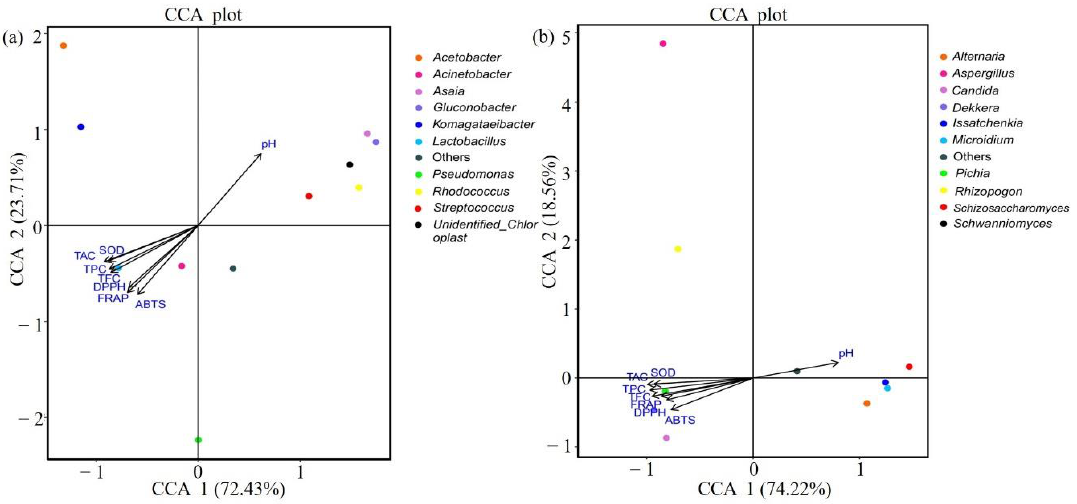
Figure 5. Redundancy analysis with environmental factors of bacteria ( a ) and fungi ( b ) in all samples. Note: The figure shows only the top 10 genera in terms of relative microorganism abundance.